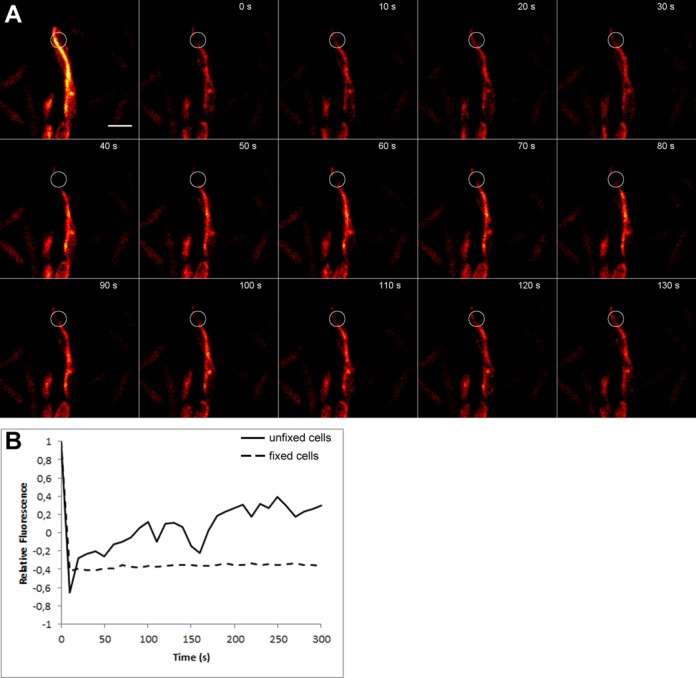
FRAP analysis of AlpC-mCherry. Cells encoding AlpC-mCherry were induced using 5 μM mitomycin C and imaged after 60 min of induction. Cells were grown on a BHI agar pad at 30°C. Part of the AlpC-mCherry filament was bleached using a 561 nm laser as described in Material and Methods section. Images were taken every 10 s. An assembly of still images acquired for 120 s is shown in (A). The full movie can be seen in the supplemental material (Movie S4). In a control experiment cells were fixed prior to bleaching and no recovery was observed (Supplementary Figure S2 and Movie S5). (B) FRAP curves for the AlpC-mCherry strain without fixing and with fixing prior to bleaching (fixed) are shown. Values are normalized for background fluorescence and intracellular mCherry fluorescence. The curve indicates recovery that is due to incorporation of unbleached AlpC-mCherry.